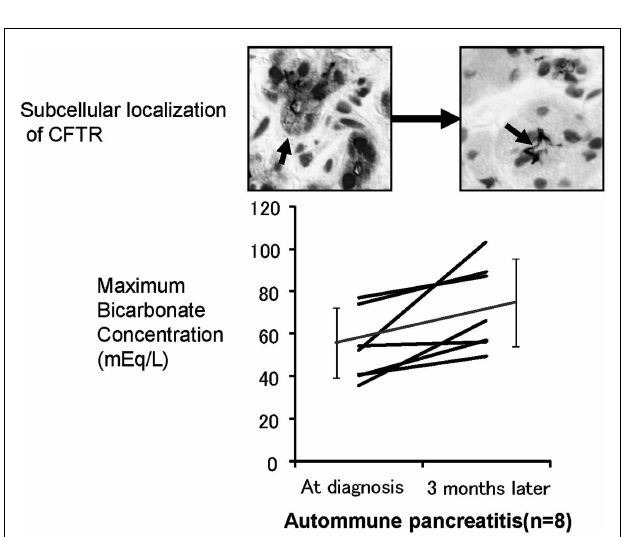
FIGURE 4 | Effects of corticosteroids on the localization of CFTR and pancreatic ductal dysfunction in autoimmune pancreatitis. The lower panel shows the changes in HCO − concentrations in the pancreatic juice of 3 autoimmune pancreatitis treated by corticosteroids.The HCO − 3 concentration in pancreatic juice is quite low prior to treatment. However, 3months of corticosteroid treatment significantly increased HCO − 3 concentration in the pancreatic juice in autoimmune pancreatitis.The upper panel shows the changes of immunolocalization of the CFTR in human pancreatic ducts (modified from Freedman, 1998). Much of the CFTR proteins were retained at the cytoplasm of small pancreatic ducts and were not transported to the proper apical plasma membrane domain (left).Three months of corticosteroid treatment completely corrected the localization of the CFTR from the cytoplasm of pancreatic ducts to the apical membrane (right).